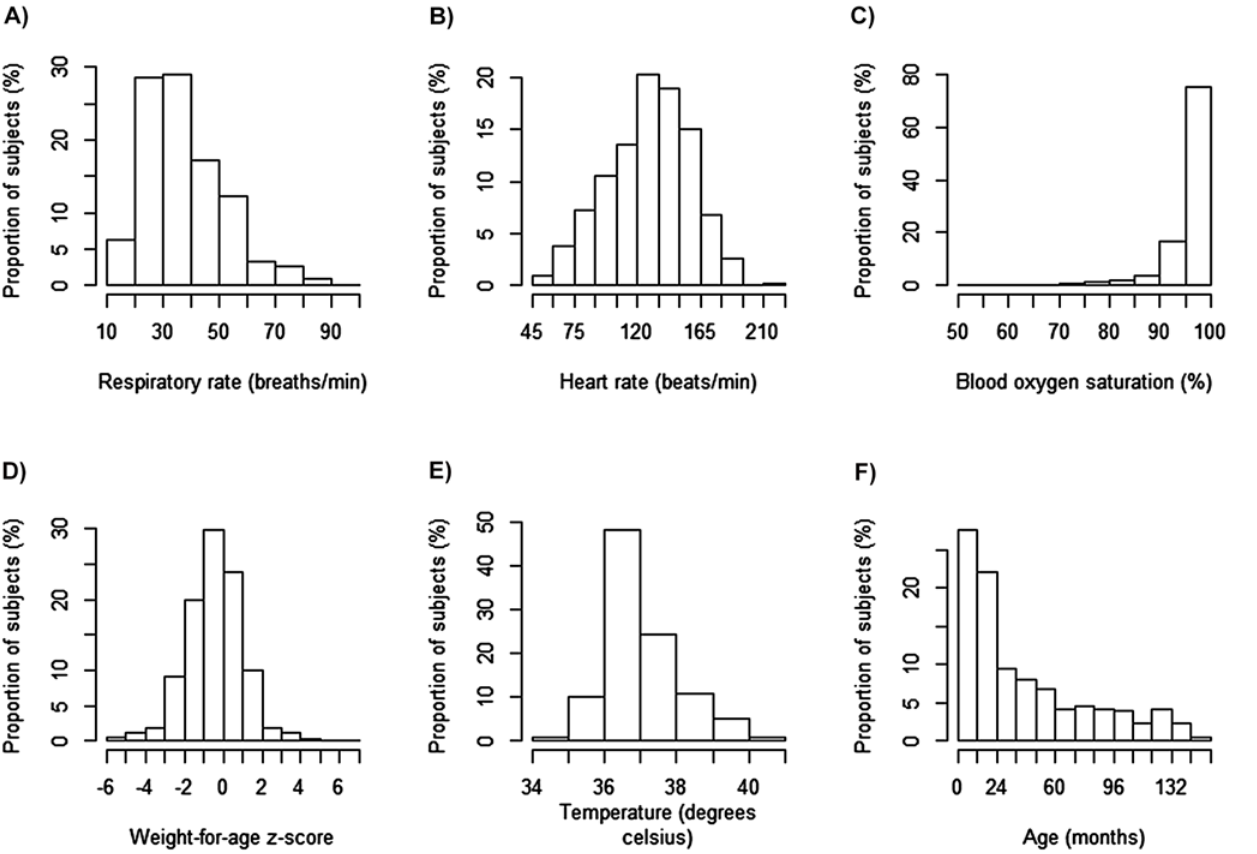
Fig 2. Histograms of important clinical variables collected at baseline from consented subjects.